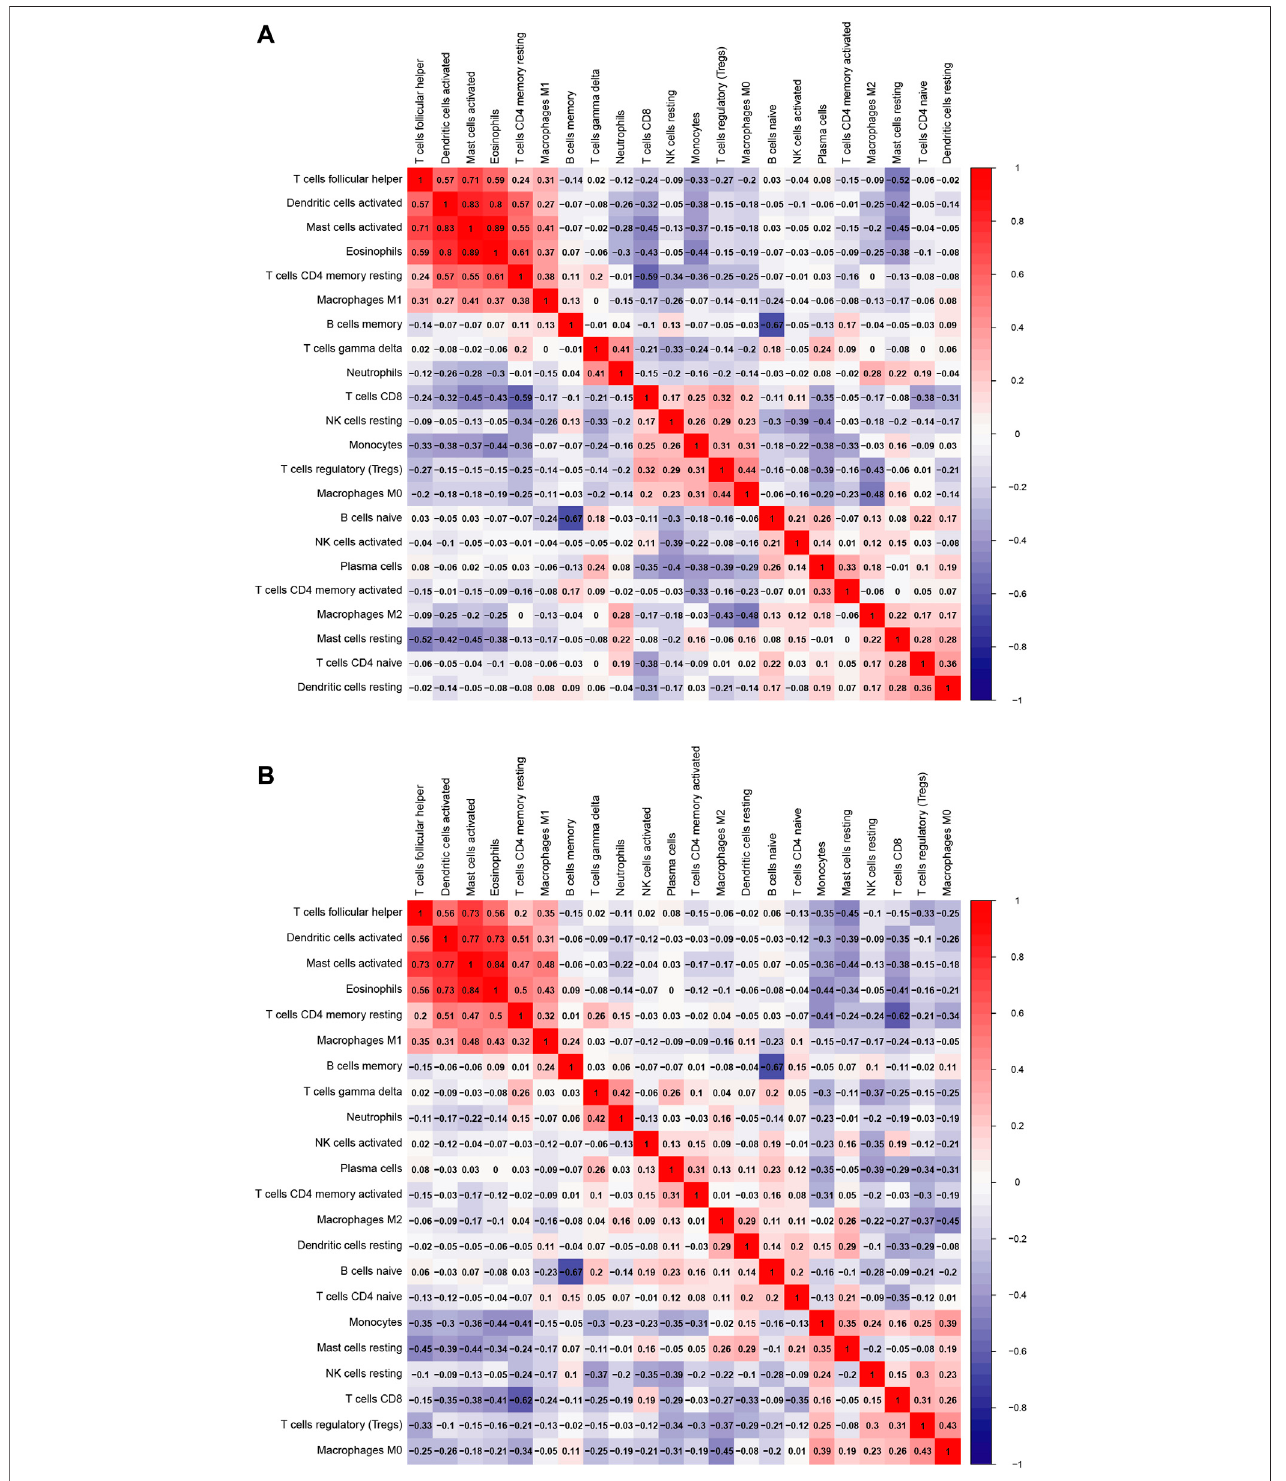
FIGURE 10 |(A) Heatmap of22 immunecells comparing OSA patients and control samples (B) Heatmap of 22immune cells comparing OSA patients before and after the use of CPAP.